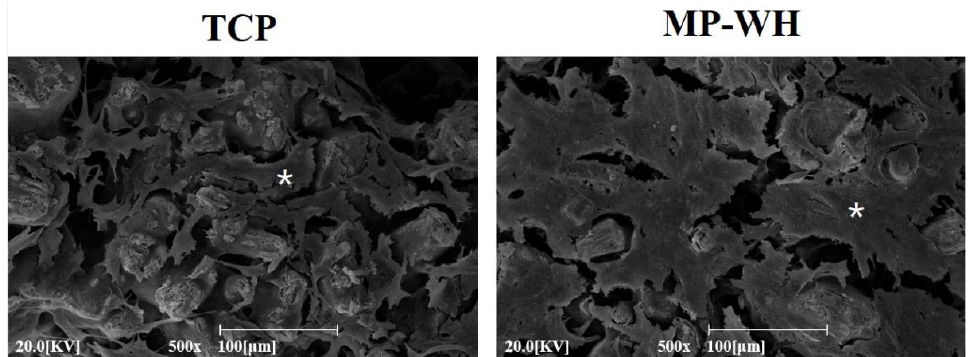
Figure 5. Scanning electron microscopy images of human mesenchymal stem cells (hMSCs) cultured on tricalcium phosphate (TCP) and marine plankton-derived whitlockite (MP-WH) 3D scaffold. Cells were seeded on TCP and MP-WH scaffolds and cell adhesion and growth were observed after 5 days of cultivation. * indicates cell growth on the scaffold.